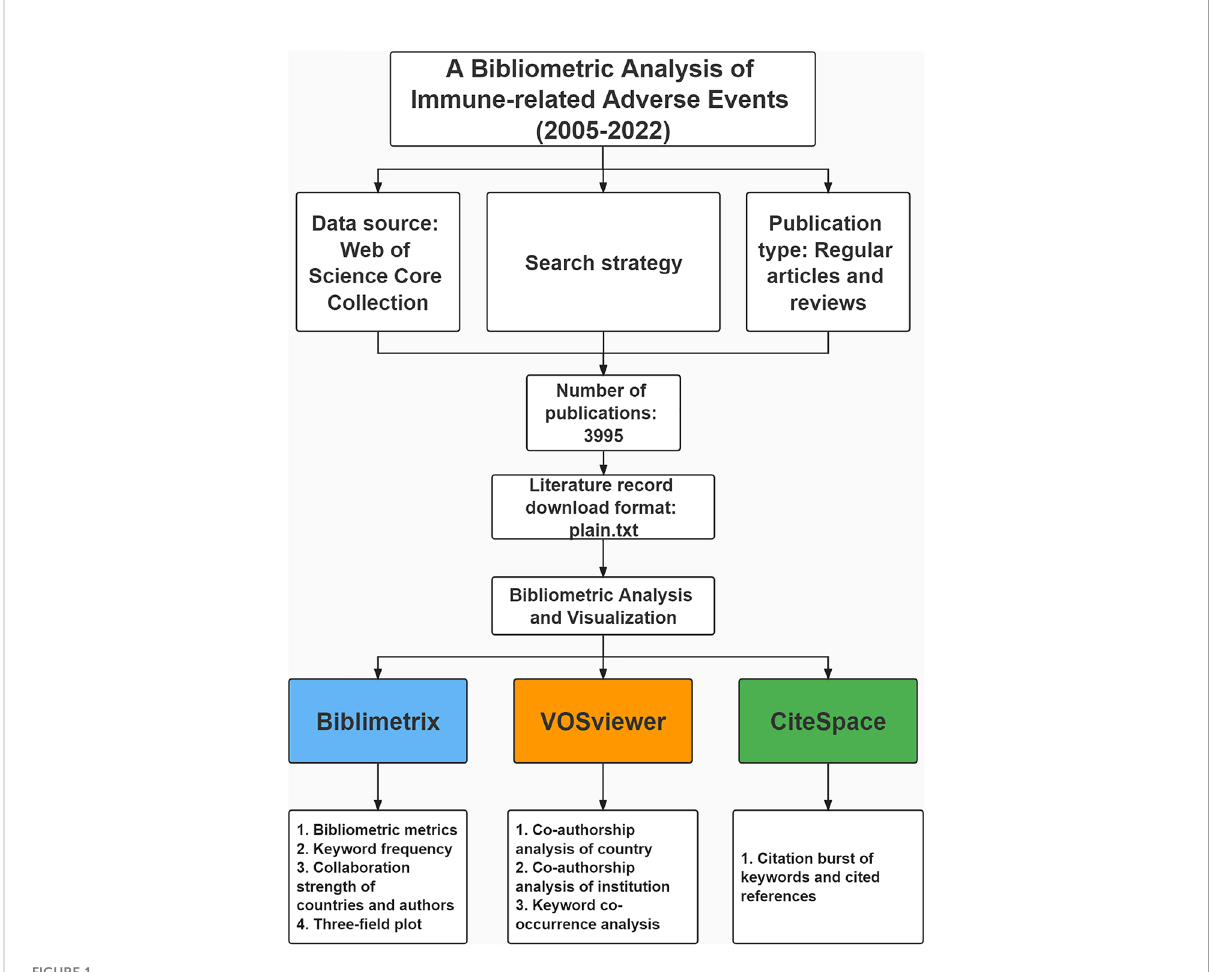
FIGURE 1 Process and key steps of the